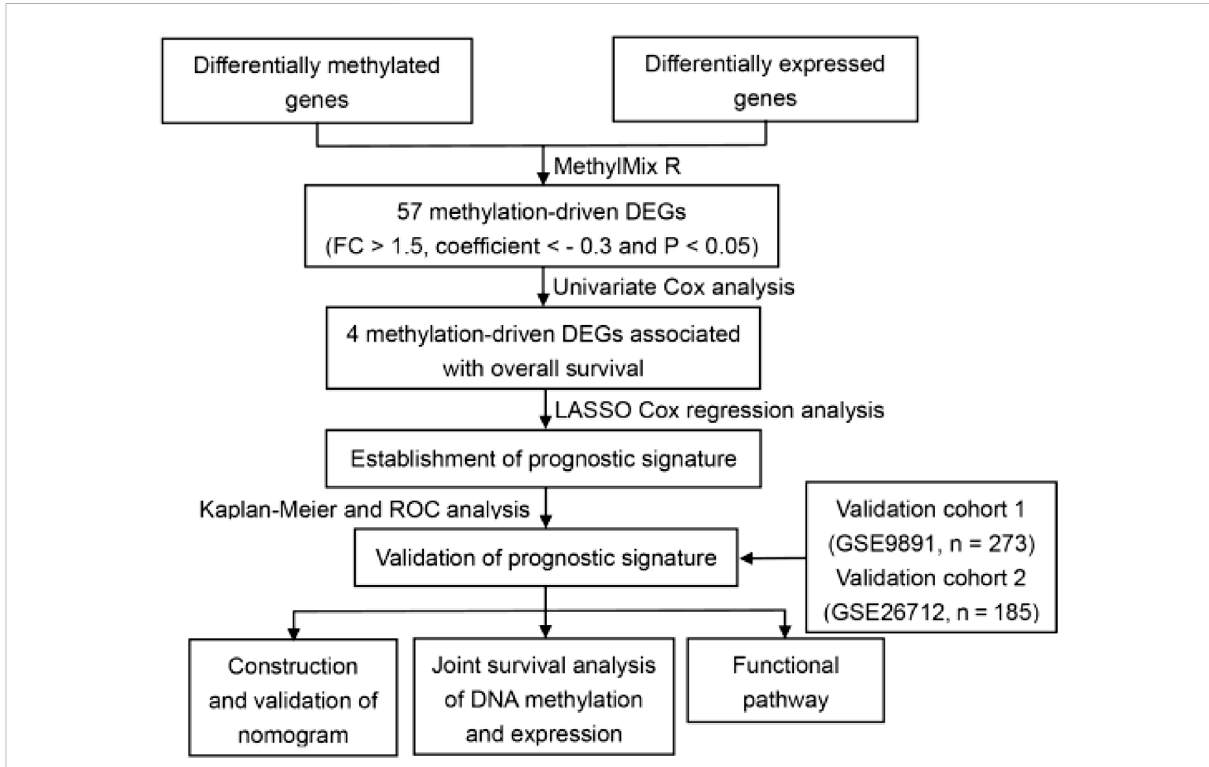
FIGURE 1 Identi fi cation of methylated related genes and fl owchart of the establishment of novel prognostic signature. (A) The fl owchart of the establishment of novel prognostic risk model for patients with ovarian cancer (OC). (B) The heatmap plot of 57 methylation related differentially expressed genes (DEGs) in OC. The color change from blue to red in the heatmap illustrates the trend from low to high